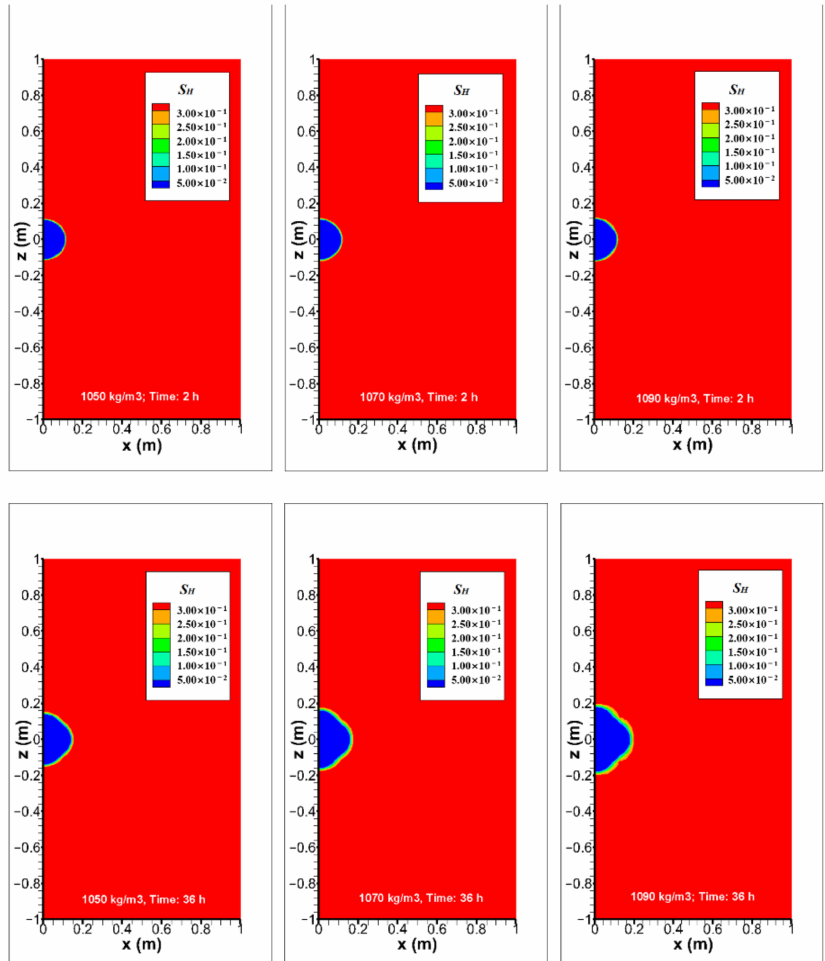
Figure 9. The NGH saturation distribution evolution of the near-wellbore reservoir with the different drilling fluid densities (without free